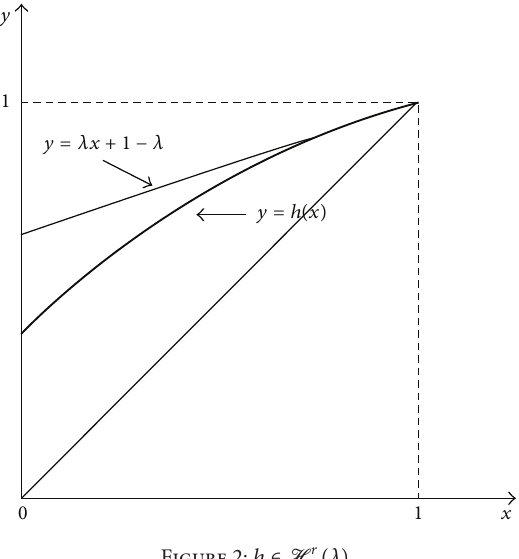
Figure 1: ℎ ∈ H 𝑟 − (𝜆) . Figure 2: